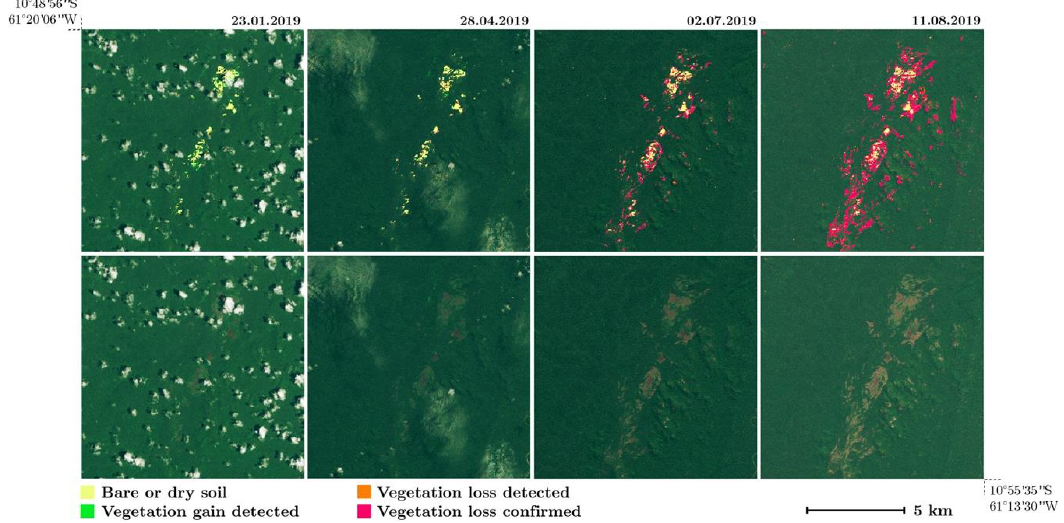
Figure 12. Upper row : results of the vegetation loss and gain detection system. Lower row : true colors image given for comparison.